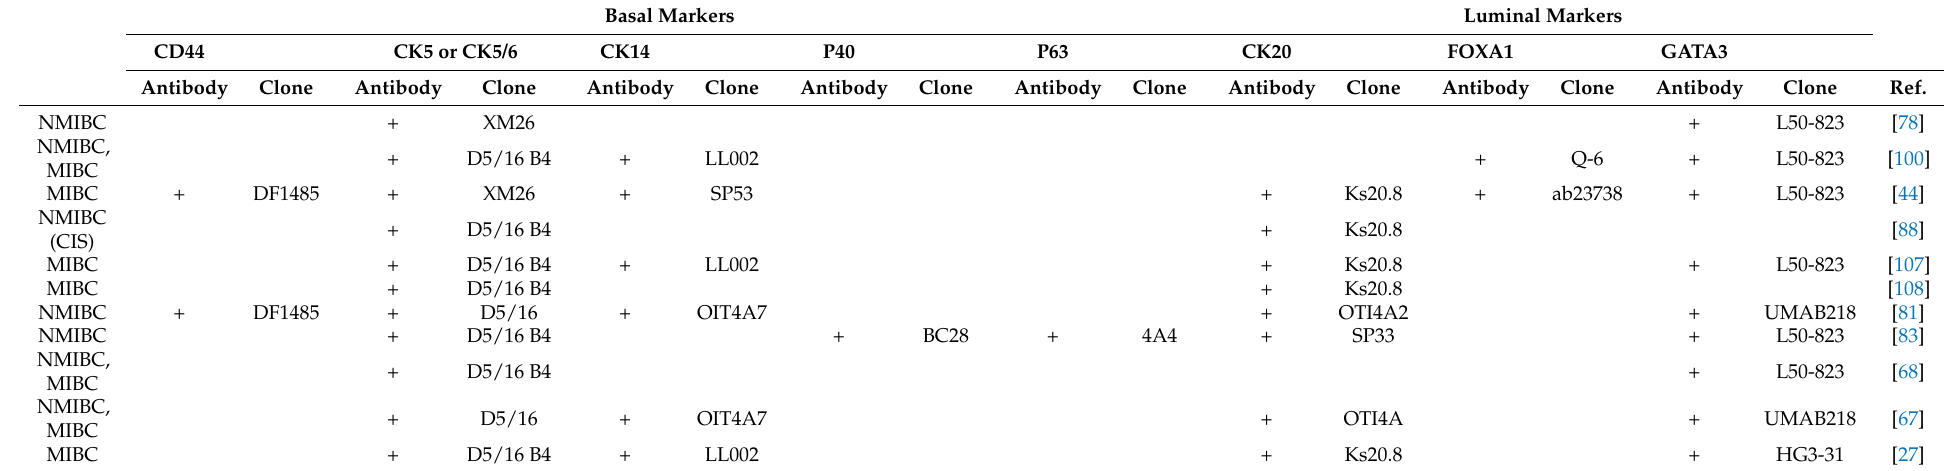
Table 3. Antibodies and clones used in selected studies (see